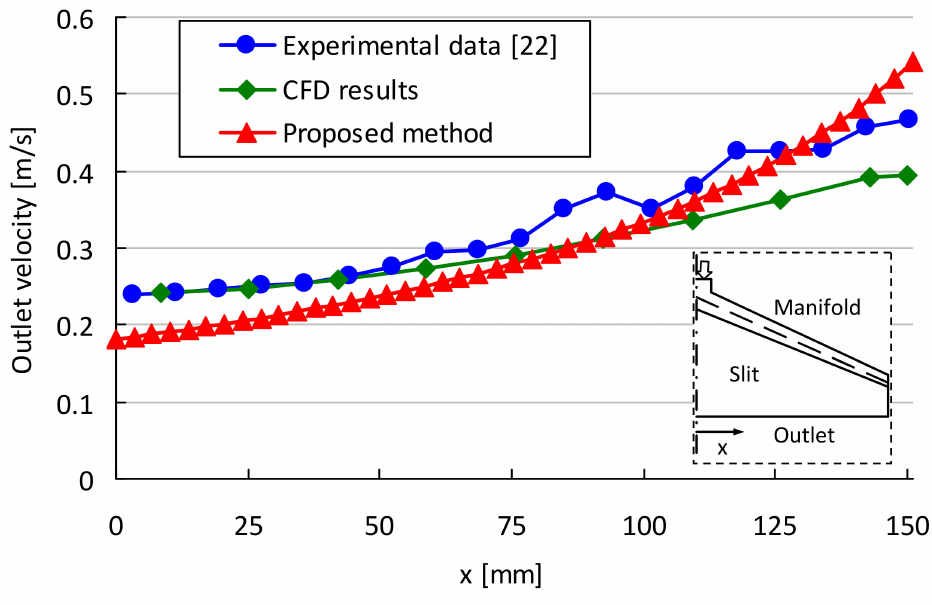
Figure 3. Validation of the model and its comparison with CFD and experimental data